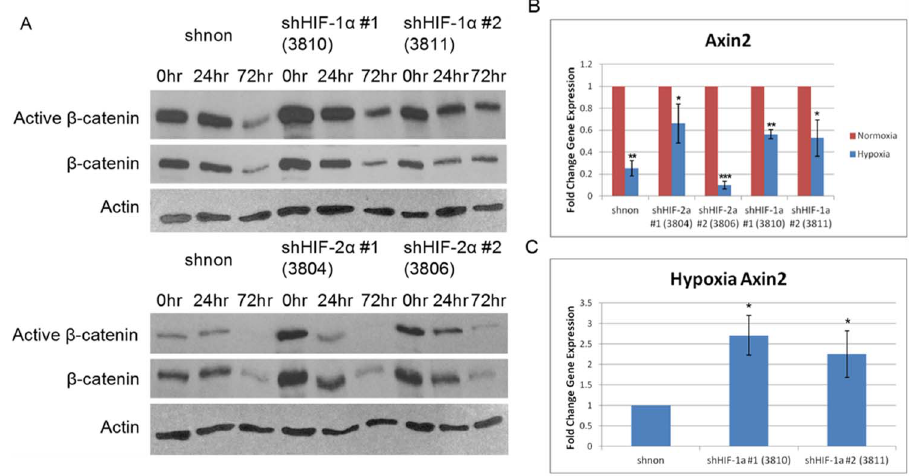
Figure 3. Wnt/ b -catenin signaling down-regulation is both dependent and independent of HIF expression. A, Levels of active b -catenin were determined by western blot at different hypoxia time points for each of the shRNA in MNNG/HOS cells. Overall levels of active b -catenin decreased regardless of HIF expression, although the magnitude of decrease was not equal across all lines. Active and total b -catenin protein levels were decreased at the 72 hour time point. Actin was the loading control. B, Decreased Wnt/ b -catenin signaling activity under hypoxia was confirmed by measuring axin2 mRNA levels via qrt-PCR in MNNG/HOS cells. Hypoxia (72 hour, 0.5% O 2 ) resulted in decreased axin2 mRNA expression relative to normoxia. C, When analyzed relative to the shnon hypoxia mRNA, axin2 mRNA was increased in the shHIF-1 a MNNG/HOS cell lines. Asterisks indicate statistical significance (*p , 0.05, **p , 0.01, ***p , 0.001). shNON: non-targeting shRNA; HIF shRNAs used are indicated in parentheses.